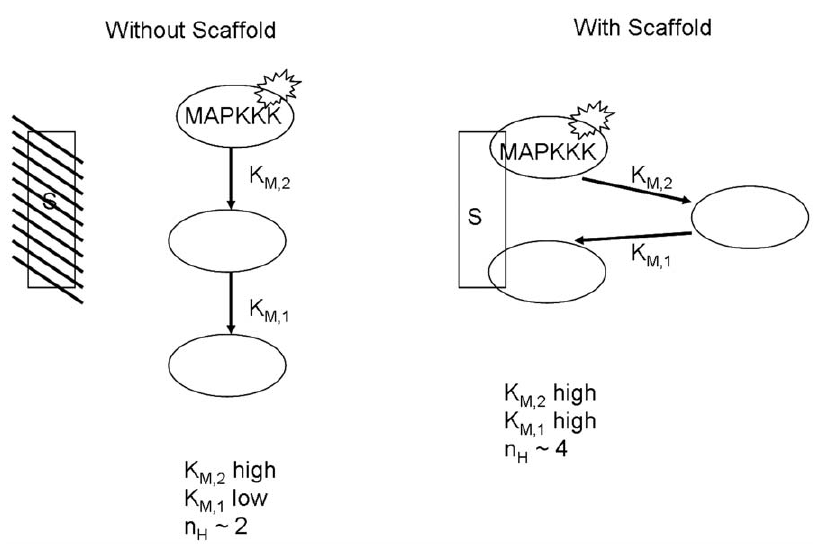
Figure 9. Schematic representation of signal transduction with constitutive MAPKKK activity in the absence (left) and presence (right) of scaffold.